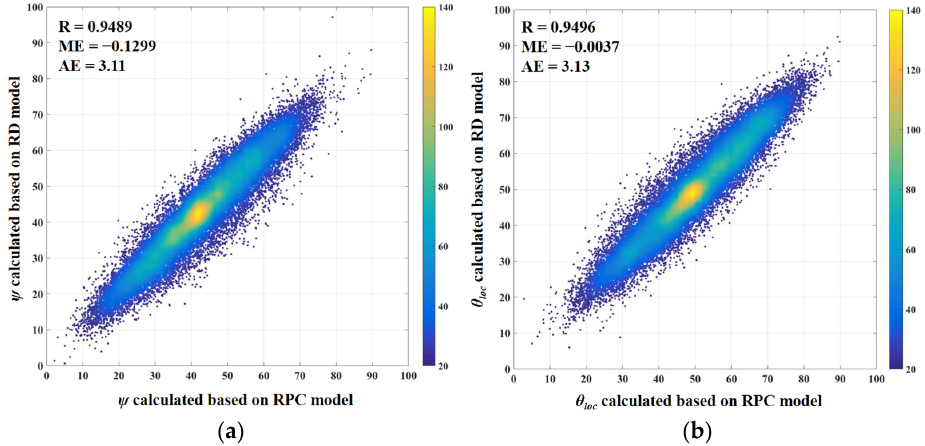
Figure 8. Calculation accuracy of local imaging geometric angle compared with the angle calculated based on RD model using Gamma software (version: 2012). ( a ) Projection angle ( ψ ); ( b ) Local incidence angle ( θ loc ). ME: Mean Error; AE: Absolute